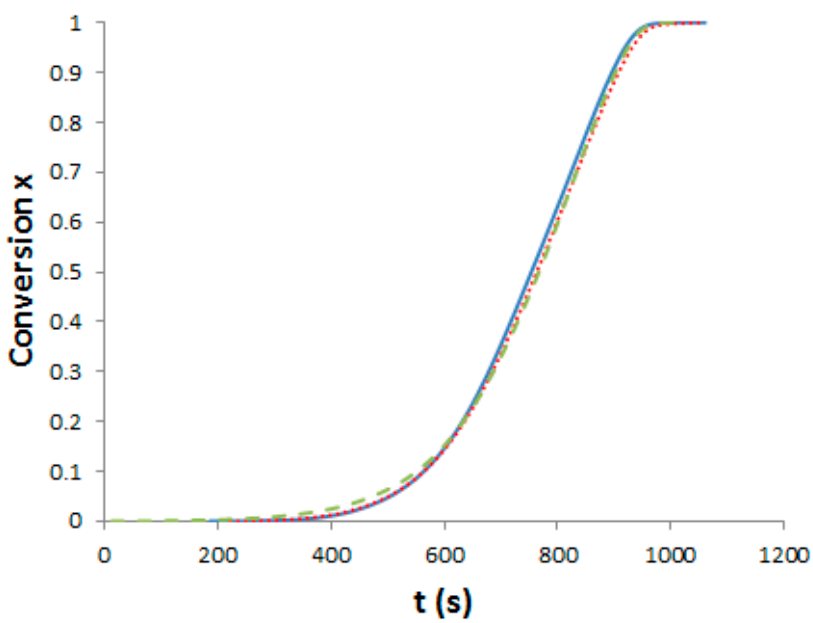
Figure 3. Evolution of the TS conversion versus time under non-isothermal conditions (10 °C/min). Full line: Neat system; dot line: f-PES system; dash line: nf-PES system.